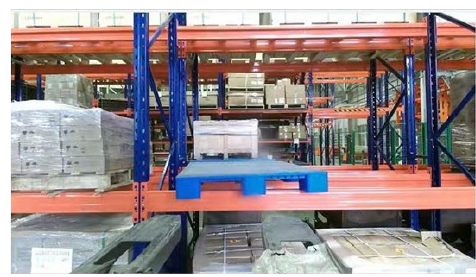
Figure 13. Color image of the shelf.